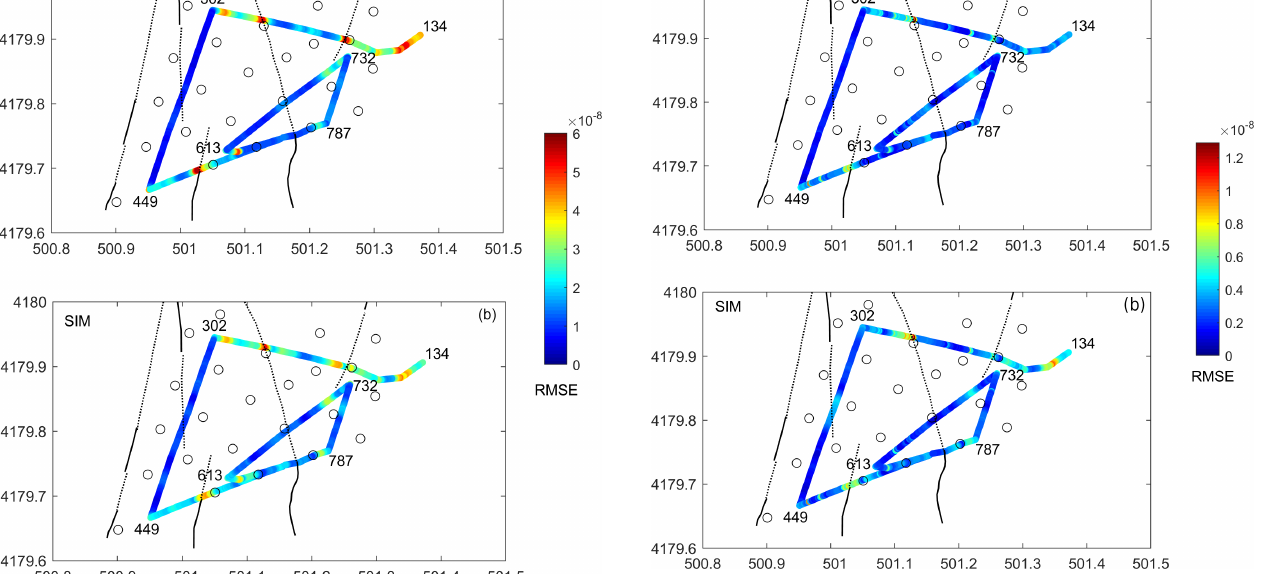
Figure 3. RMSE residuals between DAS strain measurements (Fig. 2a) and the strain derived from the seismic array along the fibre for the VE event. (a) DAS vs. the seismo-geodetic method (SGM). (b) DAS vs. the spatial interpolation method (SIM). Black lines and open circles indicate faults and seismometers shown in Fig. 1, respectively. The numbers refer to the fibre channel indices at the main cable corners. For more details, see the text.